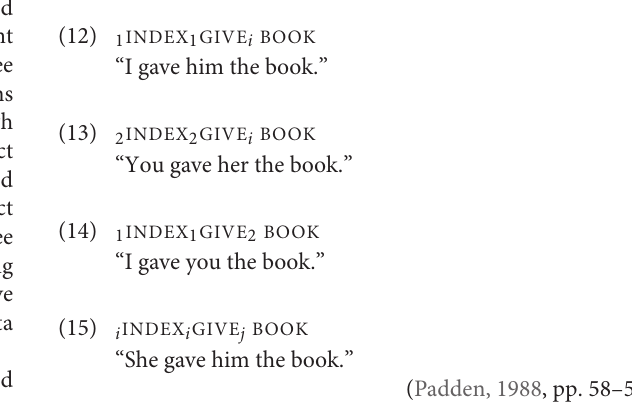
TABLE 3 | Count summary of active and passive/reflexive construction types for three verbs.